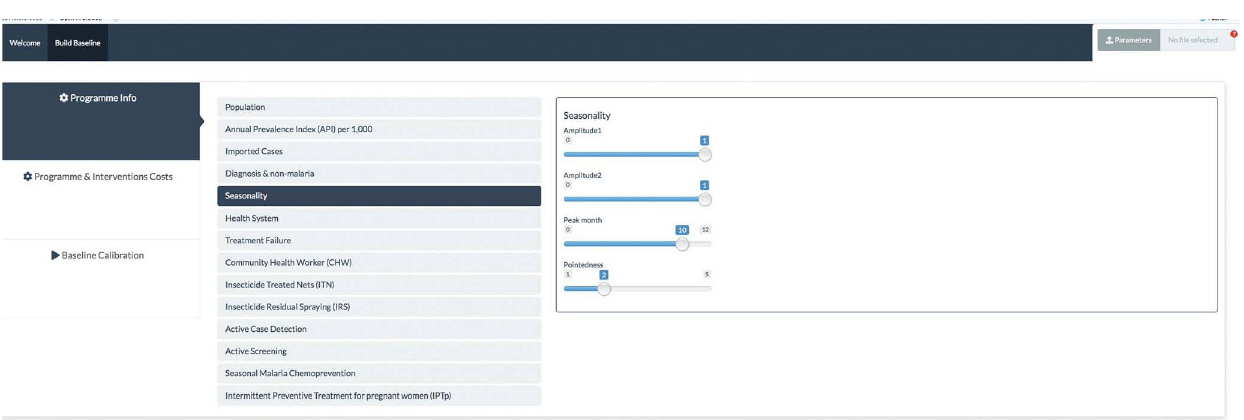
Fig 5. Changes to input sliders for amplitude parameters of the Guinea savannah model code.